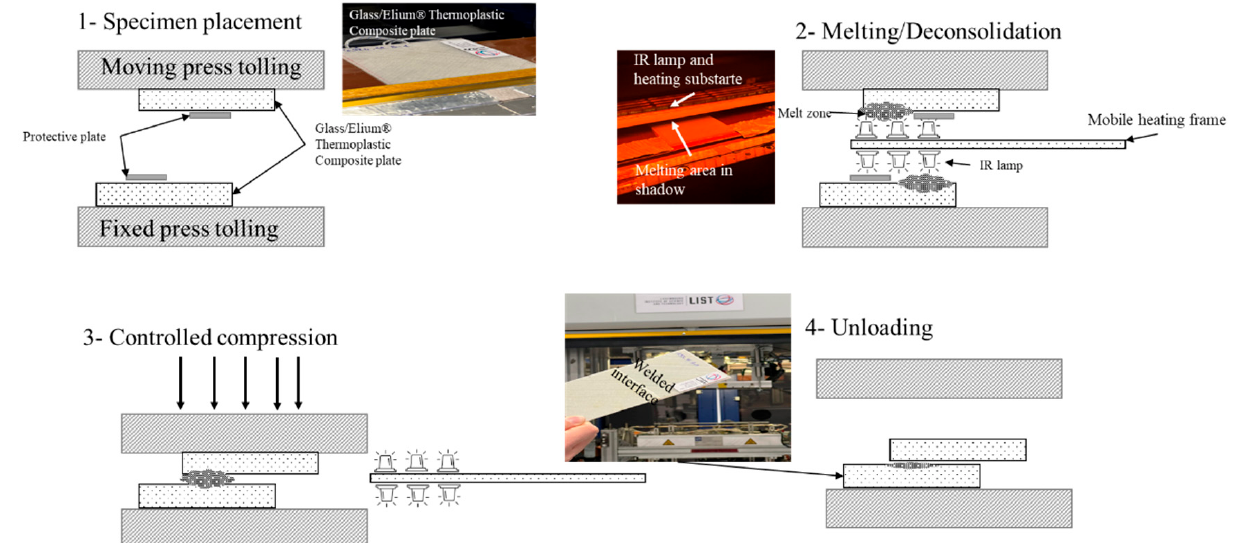
Figure 4. Descriptive IR welding process for Elium ® thermoplastic welding: (1) specimen placement, (2) melting/deconsolidation, (3) controlled compression, and (4) unloading.